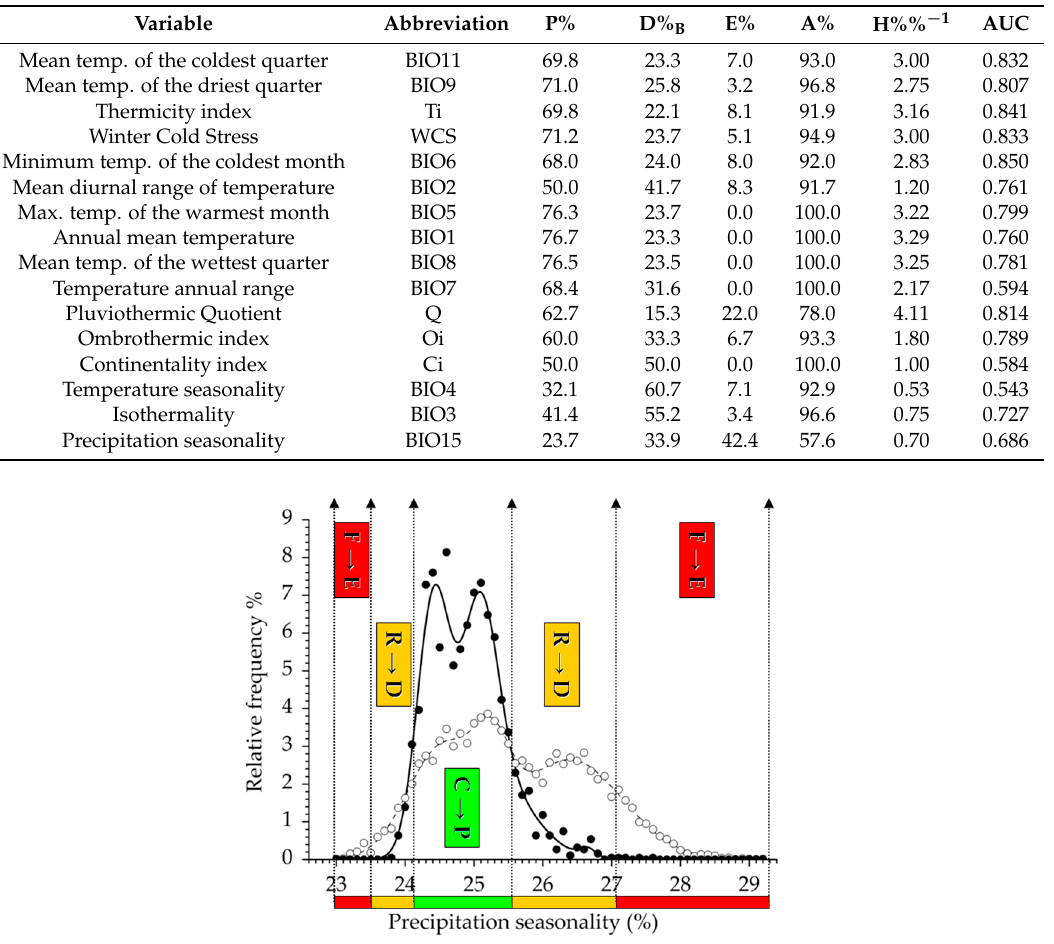
Figure 2. Prevalence–Decay-Exclusion (PDE) response functions derived from Coping–Resilience- Failure (CRF) climatic trait ranges of beech forests (e.g., Precipitation seasonality as an example). Coping range refers to Prevalence response function (C → P; green bar); Resilience range shows the Decay response function (R → D; orange bars); and Failure range identifies the Exclusion response function (F → E; red bars). Filled dots and solid line indicate relative frequency and functional response curve of beech forests, respectively, while empty dots and dashed line refer to those of the geographic area (climatic surface). CRF ranges are calculated from the disparity of functional response curves of the region and beech forests (e.g., coping range is defined if beech forests relative frequency is higher than that of the region).